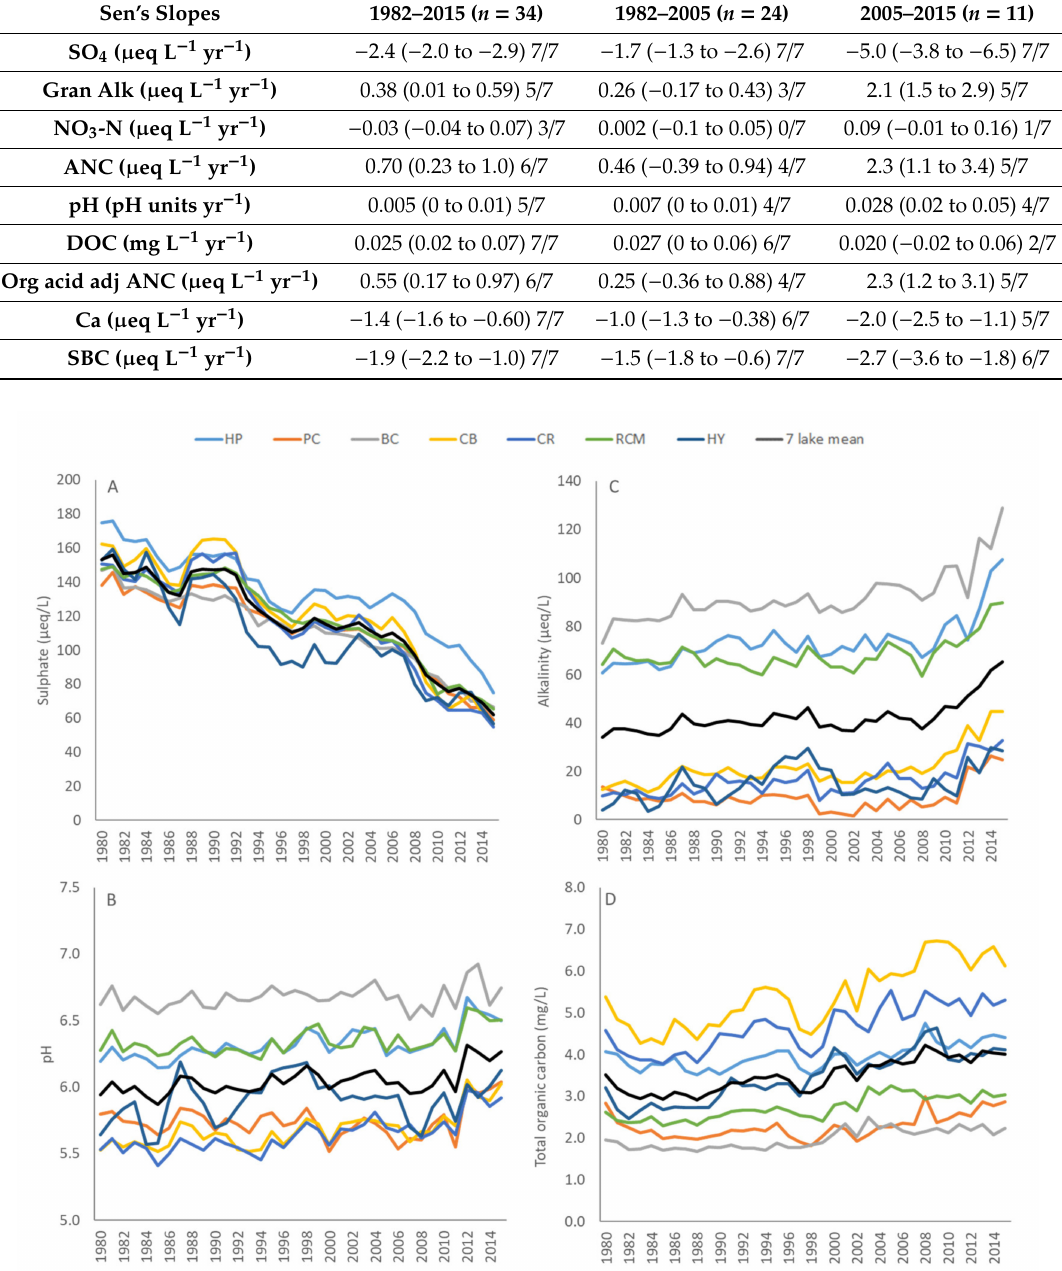
Figure 3. Change in volume-weighted sulphate ( A ), pH ( B ), alkalinity ( C ) and total organic carbon ( D ) in the seven study lakes between 1982 and 2015. The mean value of the seven lakes is shown as a solid black